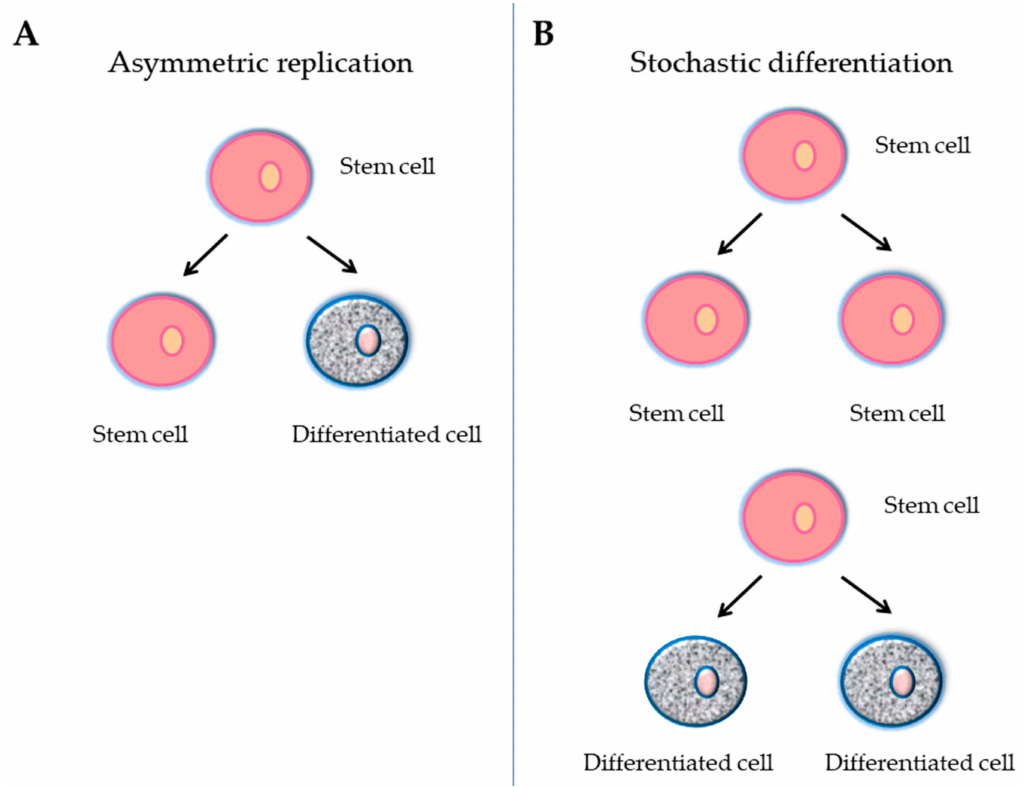
Figure 1. Schematic representation of a stem cell division in relation to self-renewal and the repopulation potential. ( A ) Asymmetric replication, giving rise to a differentiating cell and a stem cell; this division maintains the stem cell pool; ( B ) Stochastic model of division, giving rise to two stem cells with higher repopulation potential or to two differentiated